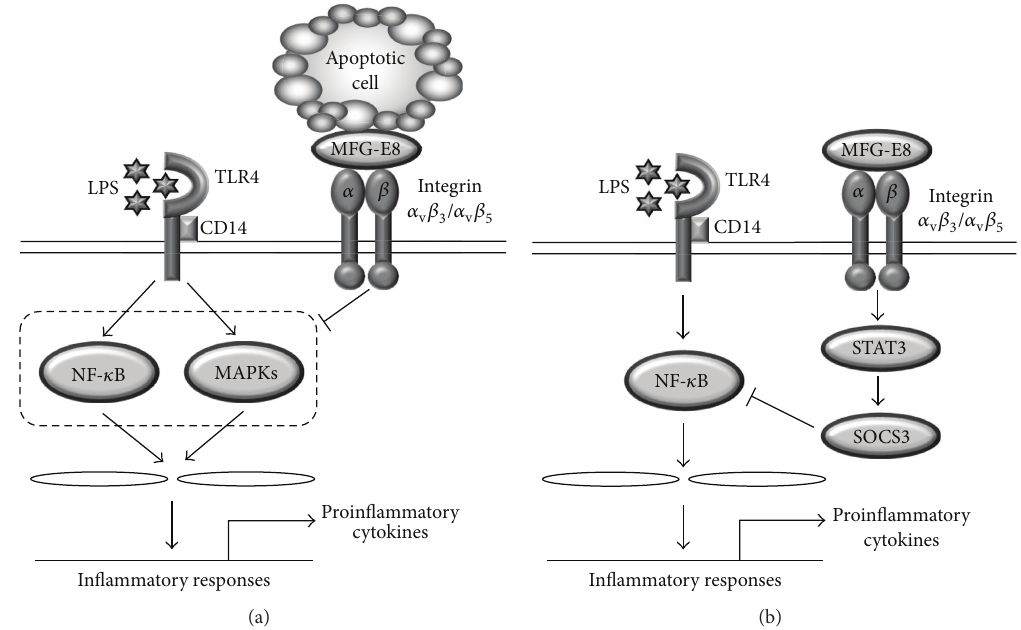
Figure 3: Anti-inflammatory mechanisms of MFG-E8 in a LPS-TLR4 signaling pathway. (a) Apoptotic cell-dependent anti-inflammatory role of MFG-E8. MFG-E8 mediates the phagocytosis of apoptotic cells, leading to the suppression of proinflammatory cytokine production through the inhibition of NF- 𝜅 B and MAPK signaling pathways. (b) Apoptotic cell-independent anti-inflammatory role of MFG-E8. MFG- E8 binds with integrin 𝛼 v 𝛽 3 /𝛼 v 𝛽 5 and induces STAT3-mediated SOCS3 activation, leading to the inhibition of the NF- 𝜅 B signaling pathway, thereby suppressing the production of proinflammatory